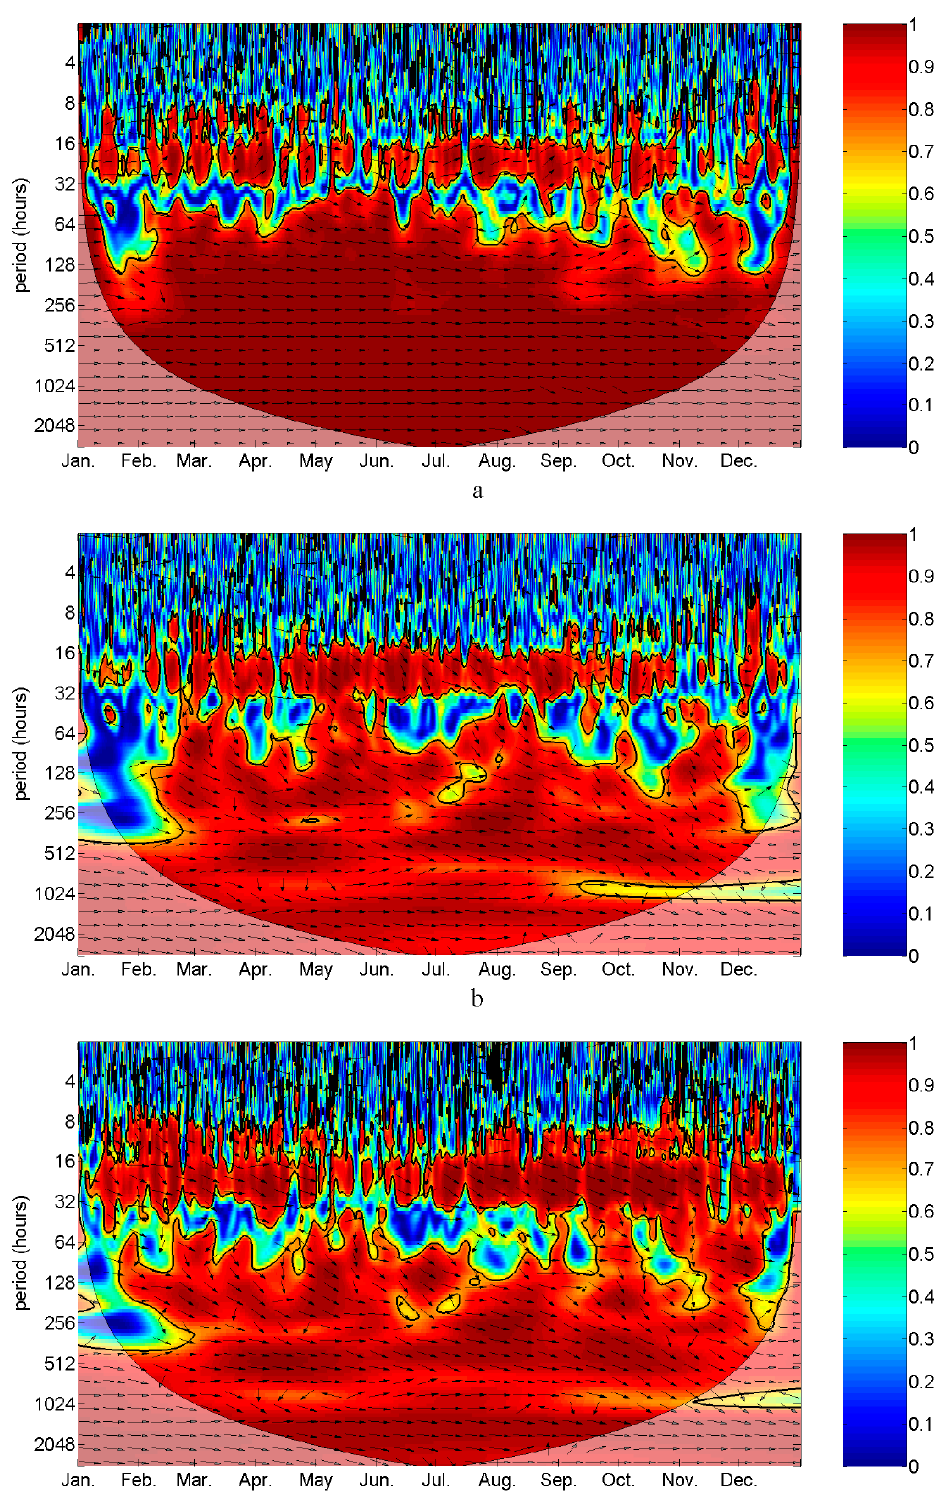
Figure 9. Wavelet coherence analysis of hourly water and air temperature time series of Suceava city in 2019: ( a ) Suceava River water temperature upstream and downstream, ( b ) air temperature at Suceava Weather Station and Suceava River water temperature upstream, ( c ) air temperature in the floodplain and Suceava River water temperature downstream.